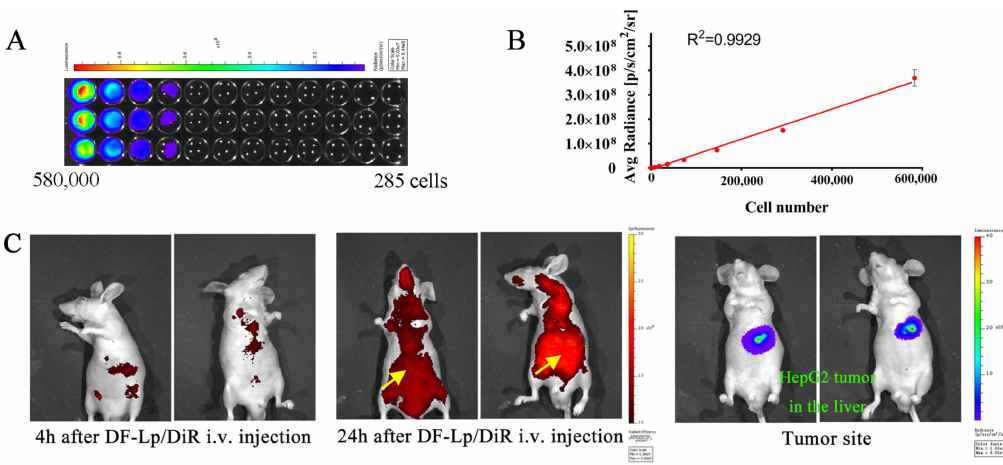
Figure 6. ( A ) In vitro imaging analysis of luciferase activity of HepG2-red-Fluc cells. ( B ) The photon flux plot as a function of increasing number of HepG2-red-Fluc cells obtained from IVIS each well ( n = 3). ( C ) Representative in vivo imaging of the HCC orthotopic mice bearing luciferase-expressing tumors derived from HepG2-red-Fluc cells following i.v. injection of DF-Lp / DiR using the IVIS imaging